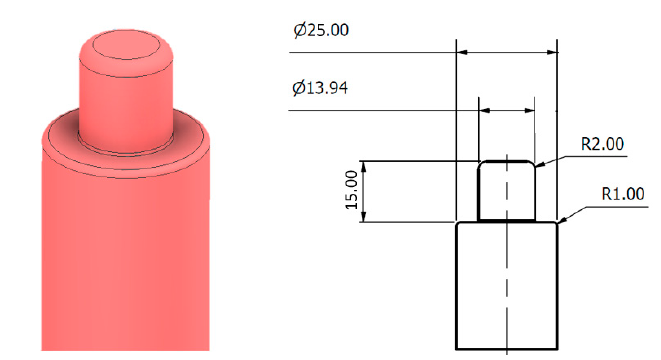
Figure 4. Shaft for gear wheel type: